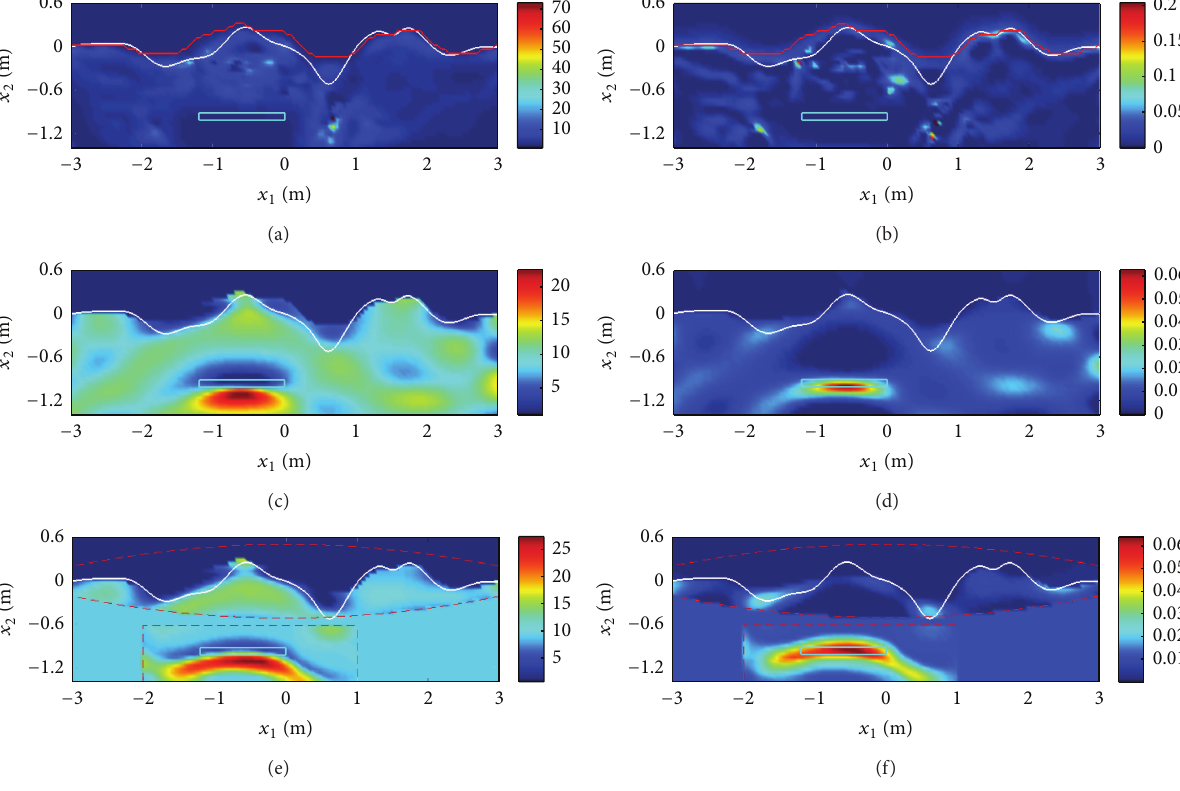
Figure 11: (a) Reconstructed permittivity and (b) conductivity profiles and the determination of the rough surface after the first stage. Final results of permittivity and conductivity profiles ((c)-(d)) for the entire domain and ((e)-(f)) for the narrowed